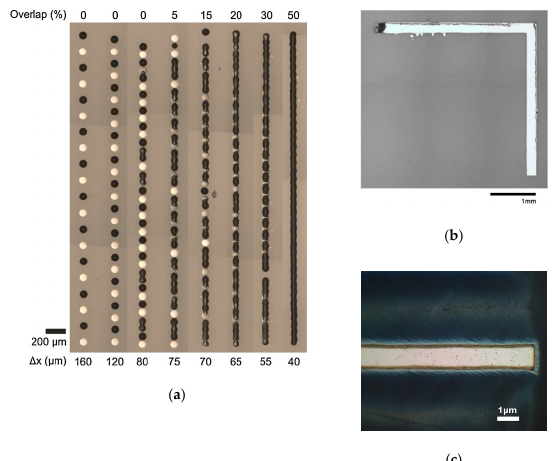
Figure 5. Optical microscopy images of: ( a ) Lines of droplets printed in alternate sequence with different overlaps ( Δ x is measured from center to center). Dried droplets appear as bright spots. [72]. ( b ) Conductive ink printed on fluidic guides forming an angle of 90 ° [75]. ( c ) Ag conductive line printed on PEN substrate after laser sintering and patterning by laser ablation [73]. Reprinted from [72], [75], and [73], respectively, with permissions of Elsevier.